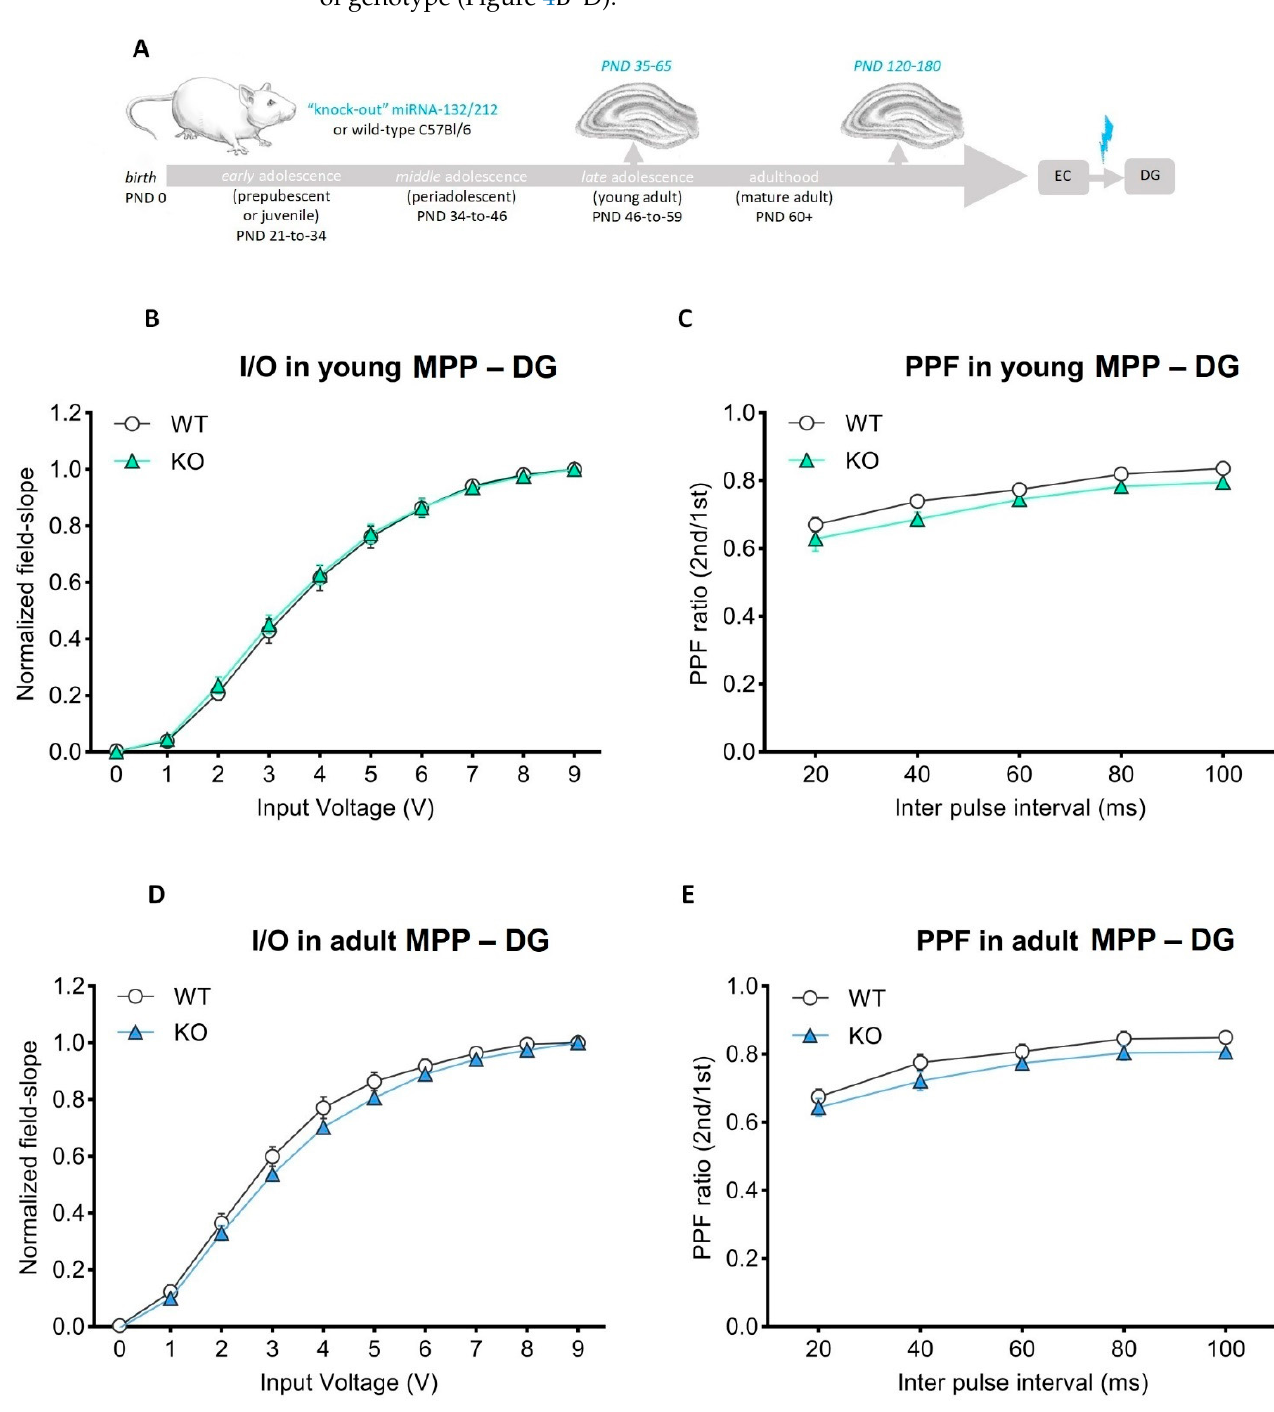
Figure 3. Basal synaptic transmission and paired-pulse-induced inhibition are unaltered in the adolescent or adult dentate gyrus of miRNA-132/212 knockout mice. ( A ) Schematic study design and experimental approach to study LTP induction at the dentate gyrus output synapses. ( B ) Averaged field slope vs. voltage stimulation (resulting from I/O protocols) in adolescent (PND 35–65) wild-type (WT, n = 10) and in miRNA-132/212 − / − (KO, n = 10) slices. No differences were apparent between groups (ns = p < 0.05; ANOVA (repeated measures) was followed by the Bonferroni test; error bars presented as SEM). ( C ) Averaged PPI ratios vs. increasing inter-pulse intervals. No differences were detected between the groups (ns = p < 0.05; ANOVA (repeated measures) was followed by the